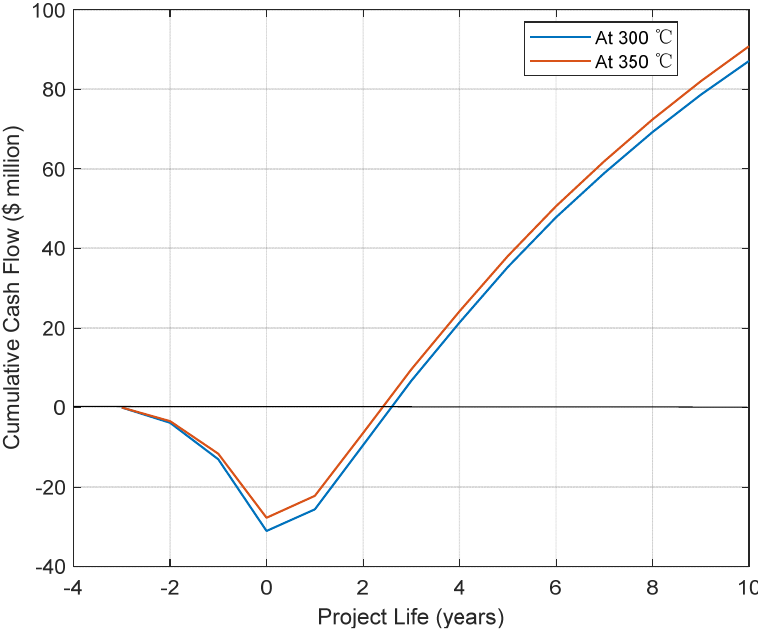
Figure 9. The cumulative cash flow diagram for both reactor temperatures.